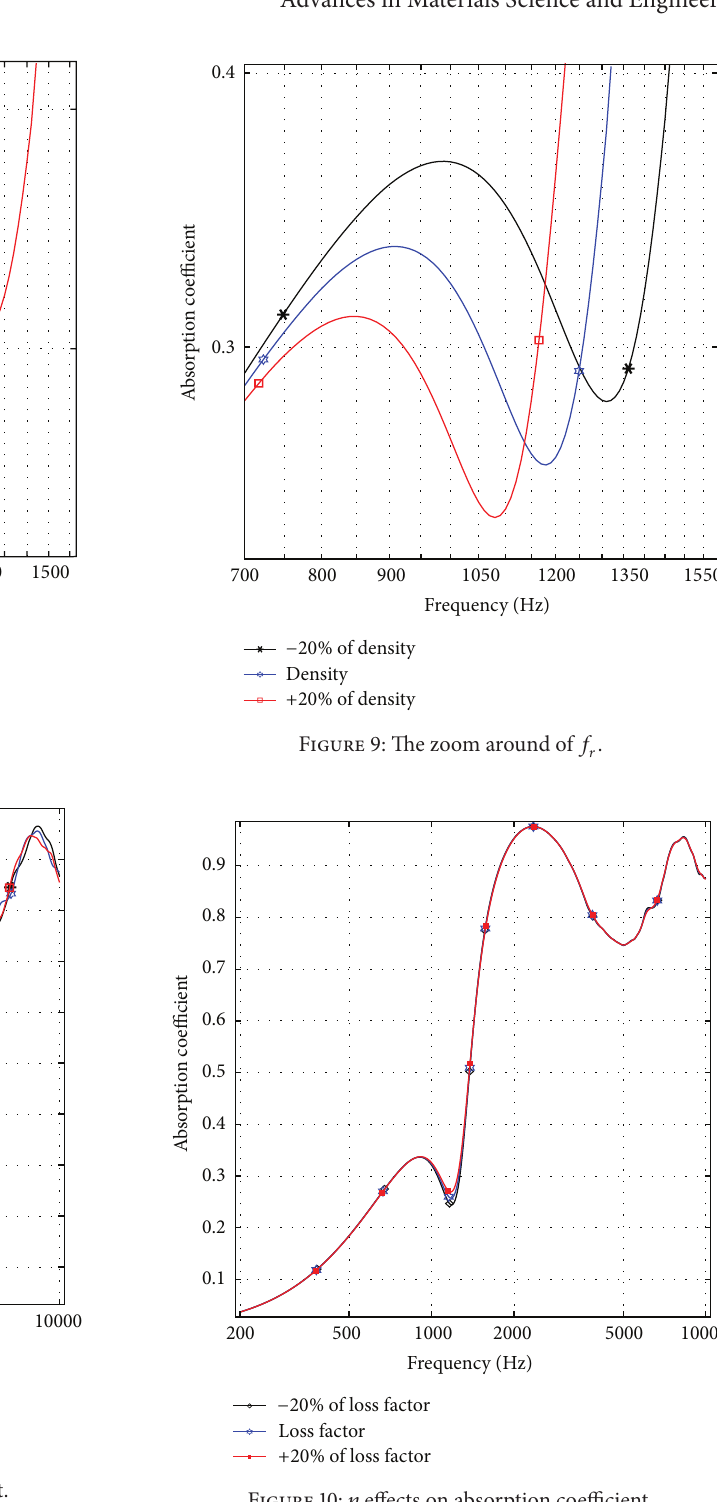
Figure 10: 𝜂 effects on absorption